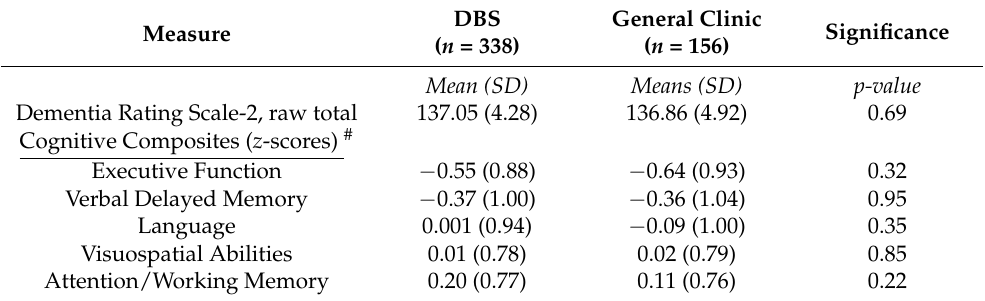
Table A1. Cognitive performance of deep brain stimulation candidates versus general clinic patients. DBS Measure